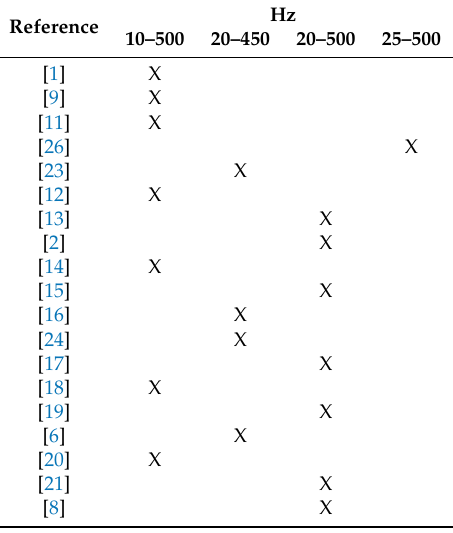
Table 1. Reported band-pass